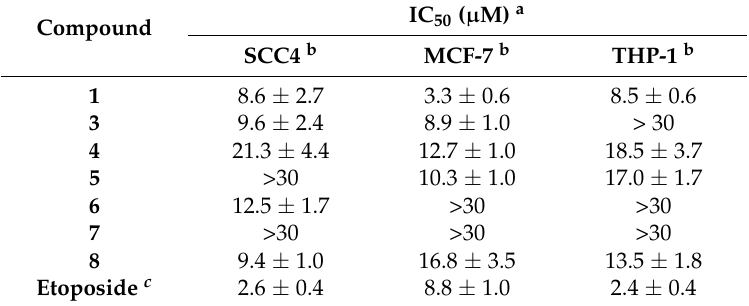
Table 1. Antiproliferative activities of compounds 1 and 3–8 against different cancer cell lines.